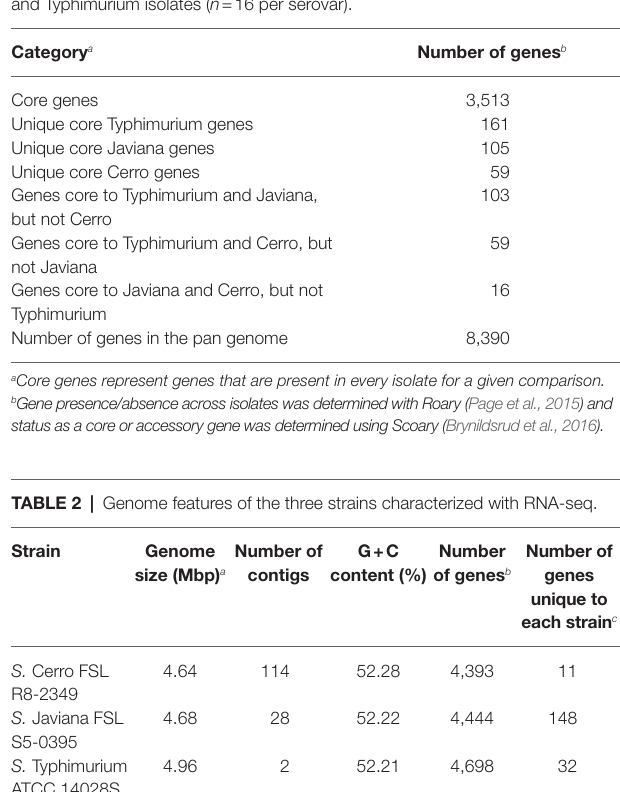
TABLE 1 | Core and accessory genome sizes among serovar Cerro, Javiana and Typhimurium isolates ( n = 16 per